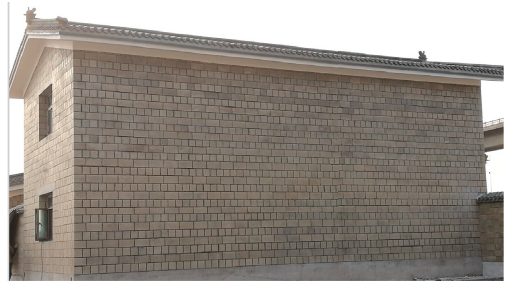
Figure 1: A two-storey hollow compressed cement-stabilized earth-block masonry structure in